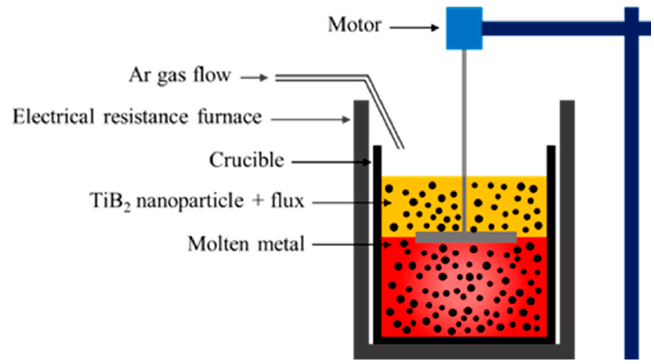
Figure 1. Schematic of the flux-assisted liquid state processing experimental setup. Characterization. Scanning electron micrographs (SEM) were acquired using a